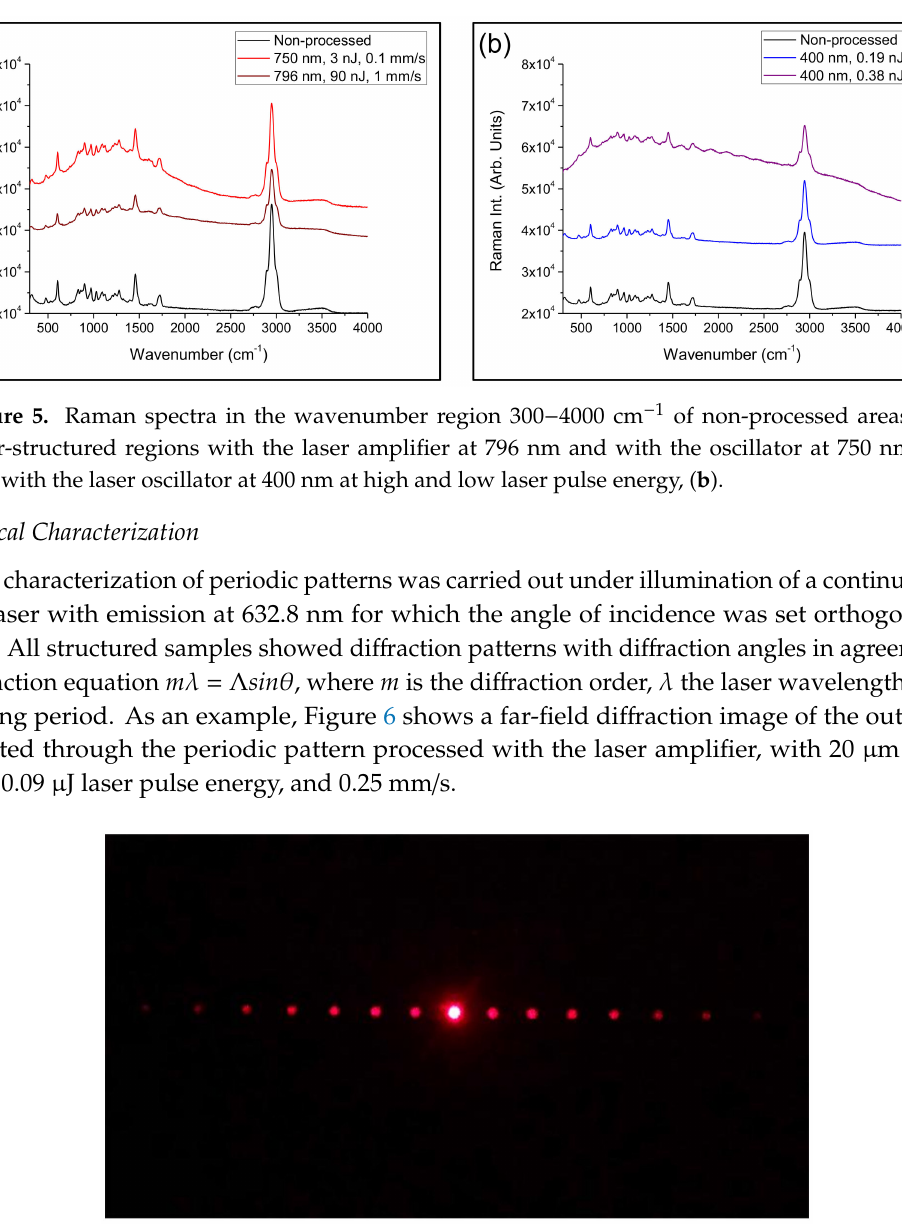
Figure 6. Far-field di ff raction image of the output beam transmitted through the periodic pattern processed with the laser amplifier at 796 nm, with 20 µ m inter-line spacing, 0.09 µ J laser pulse energy, and 0.25 mm /